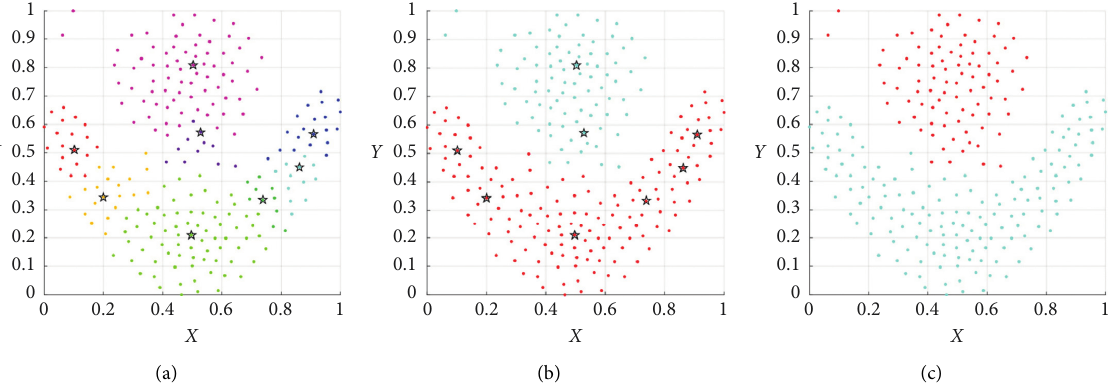
Figure 7: The clustering results of the Flame dataset. The diverse colors present different NNEGs, and the stars mark the zero samples. (a) NNEGs of flame. (b) DPC-NNEG on spiral. (c) Ground